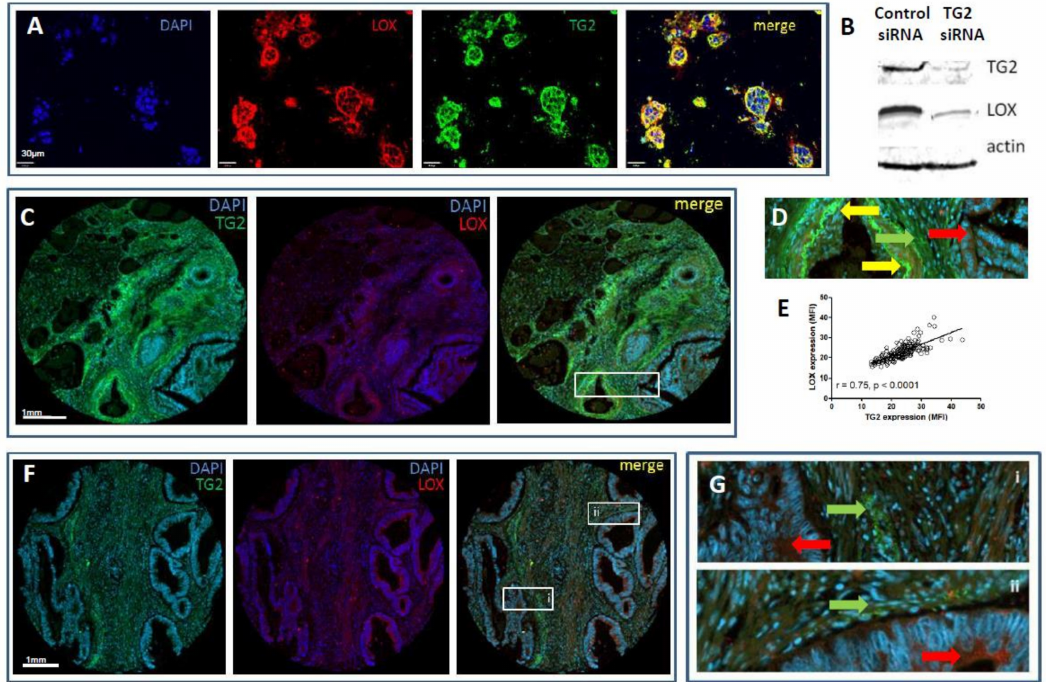
Figure 6. TG2 regulates LOX in vitro, but the enzymes have distinct expression profiles in vivo. Expression of LOX was observed at the CRC / stroma boundary of SW480 / fibroblast co-cultures ( A , red staining), which significantly co-localised with TG2 (green staining, co-localisation indicated by yellow colouration, right-hand panel). Inhibiting TG2 reduced the expression of LOX in cell lysates ( B ). To compare in vitro staining with patient tissues, a TMA was stained for both enzymes. Some co-localisation was observed ( C , yellow arrows), primarily in stromal regions ( D , magnified image of the boxed area in C ); however TG2 was observed independent of LOX in other regions of stroma (green arrows), and LOX independent of TG2 in epithelial areas (red arrows). Overall mean tissue expression of TG2 and LOX was highly correlated ( E ), which was primarily due to closely expressed, but not co-localised, staining in the tissue stroma ( F , and magnified images of boxes i and ii, G